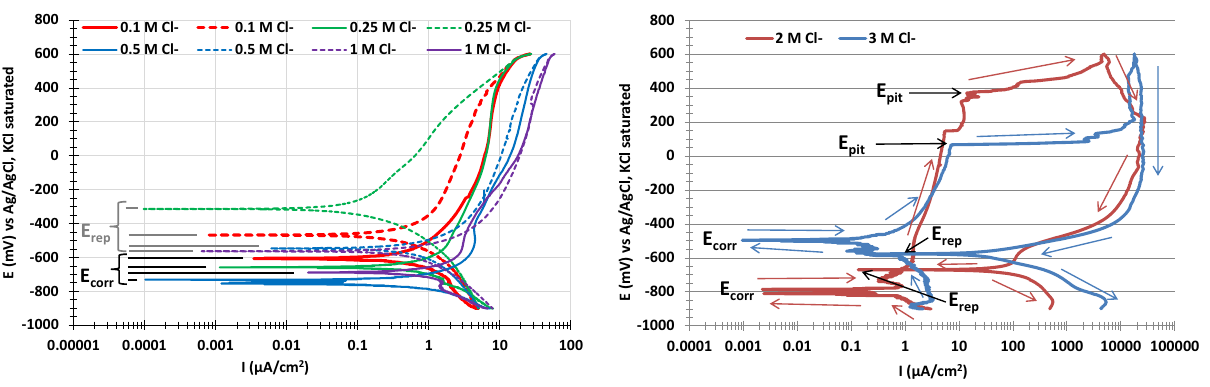
Figure 6: CPP of HSHCsw in deaerated electrolytes at pH 13.4 at 2 and 3 M Cl